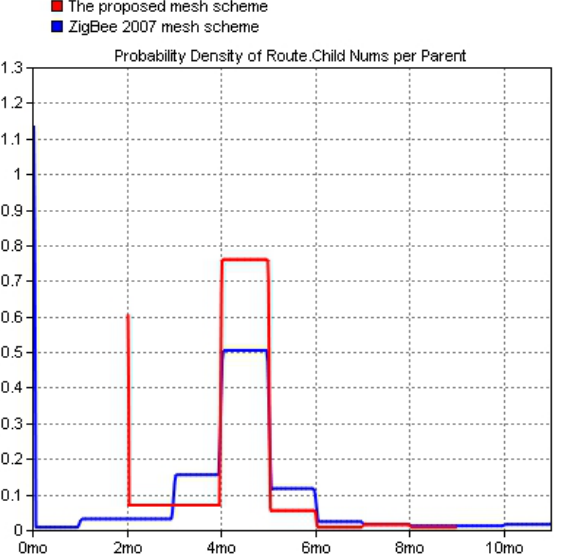
Figure 14. Ratio of terminal nodes carried by routing nodes for the proposed solution and the ZigBee 2007